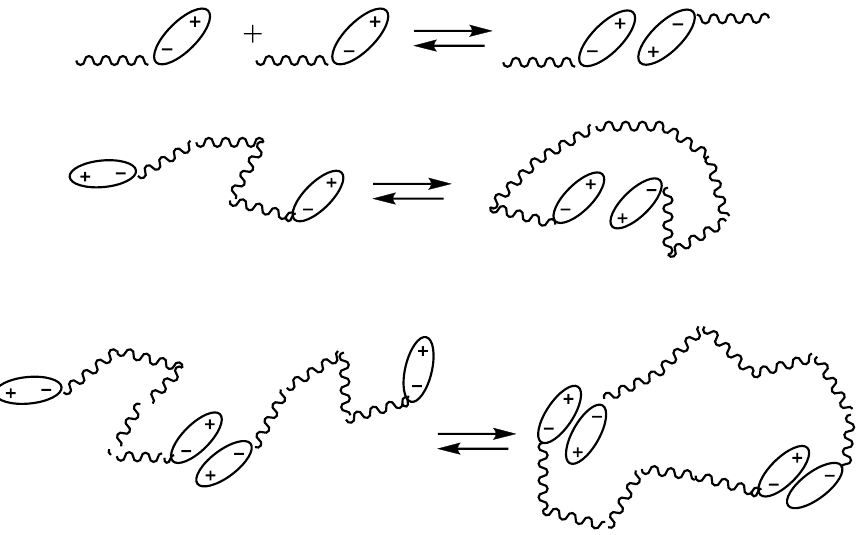
Figure 3. The mechanism of interaction between the anionic center and the siloxane bond.